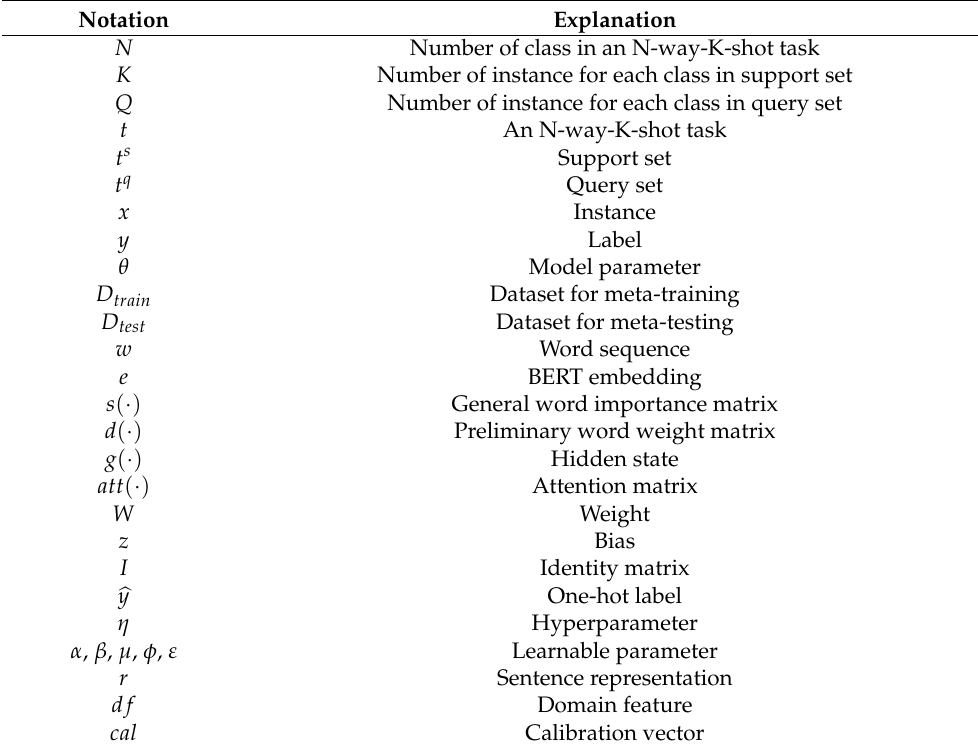
Table 1. Notations and